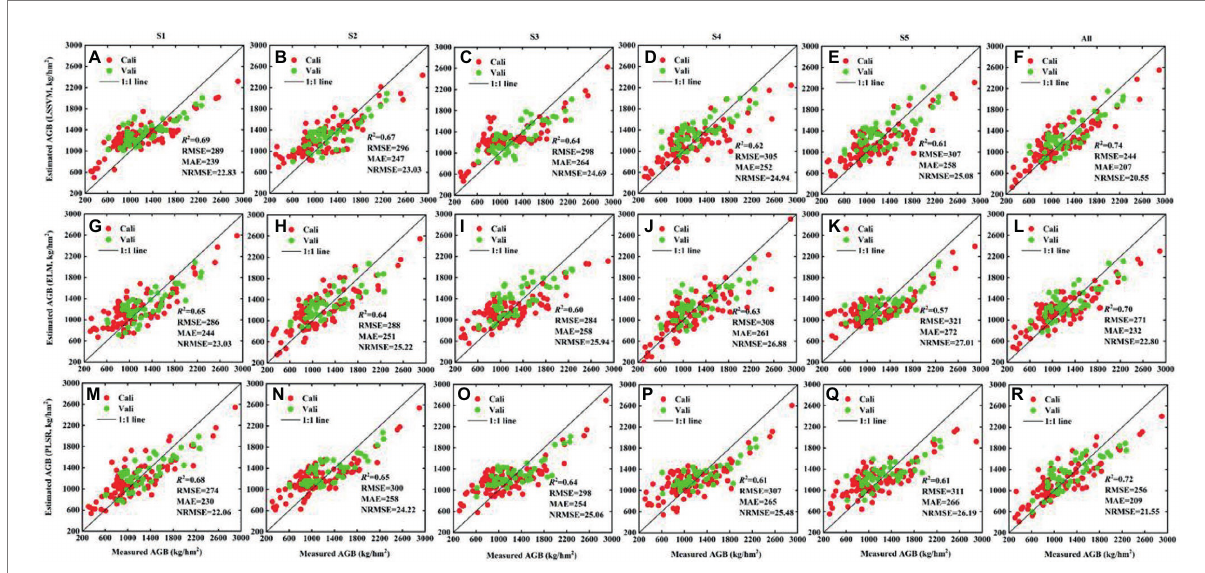
FIGURE 10 The fitted scatter plot of measuring and estimating potato AGB (kg/hm 2 ) using Gabor-based textures from S1, S5, S3, S4, S5 and all, respectively. (A–F) LSSVM; (G–L) ELM; (M–R) PLSR. “All” represent texture combinations of different scales. The estimation results of Cali and Vali are shown in Supplementary Table